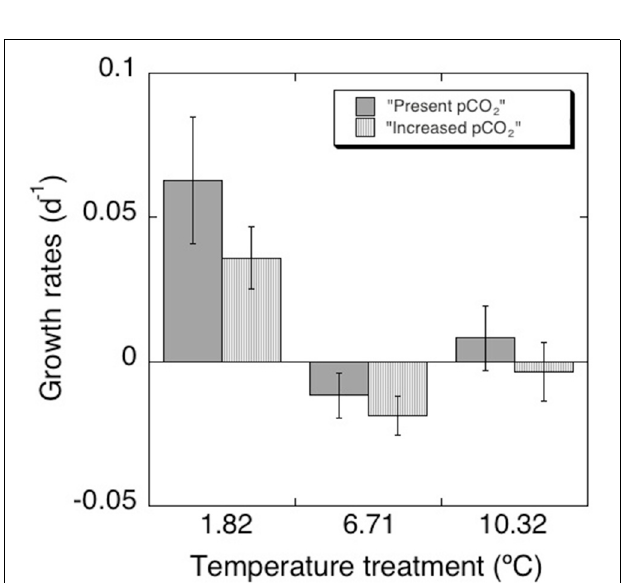
FIGURE 3 | Net growth rates (d − 1 ) calculated for each treatment with their correspondent standard errors. The growth rates estimated from cell biovolume of centric diatoms 11.1 µ m in diameter declined strongly with increas- ing temperature ( p < 0 . 01), while the growth rate of centric diatoms 7 µ m in diameter increased with warming. Increased p CO 2 caused different responses in phytoplankton, with a signif- icant growth increase of centric diatoms 7 µ m and Pyramimonas sp. with increasing p CO 2 ( p < 0 . 05), and a decline in growth rate of centric diatoms 11.1 µ m with increasing p CO 2 . A positive and